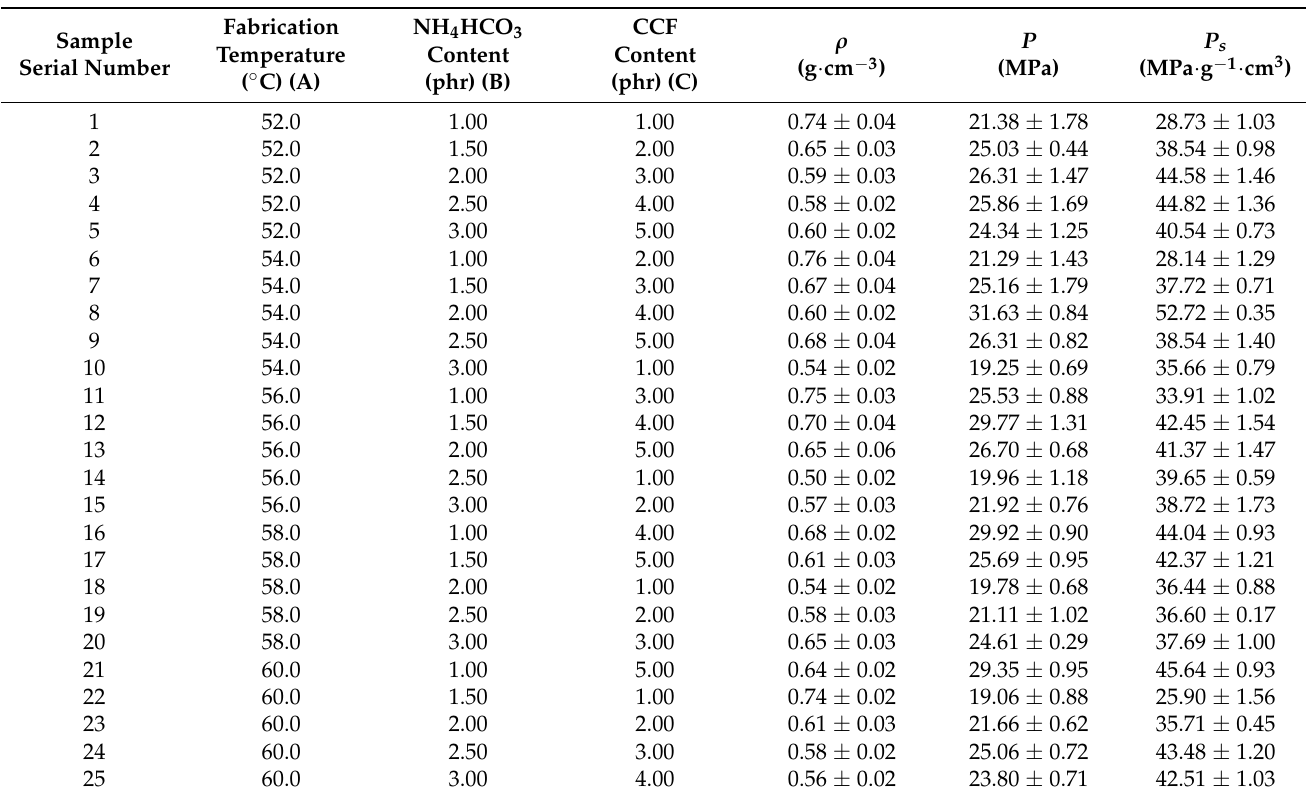
Table 4. Orthogonal design and results of CCFR-LDUPR composite